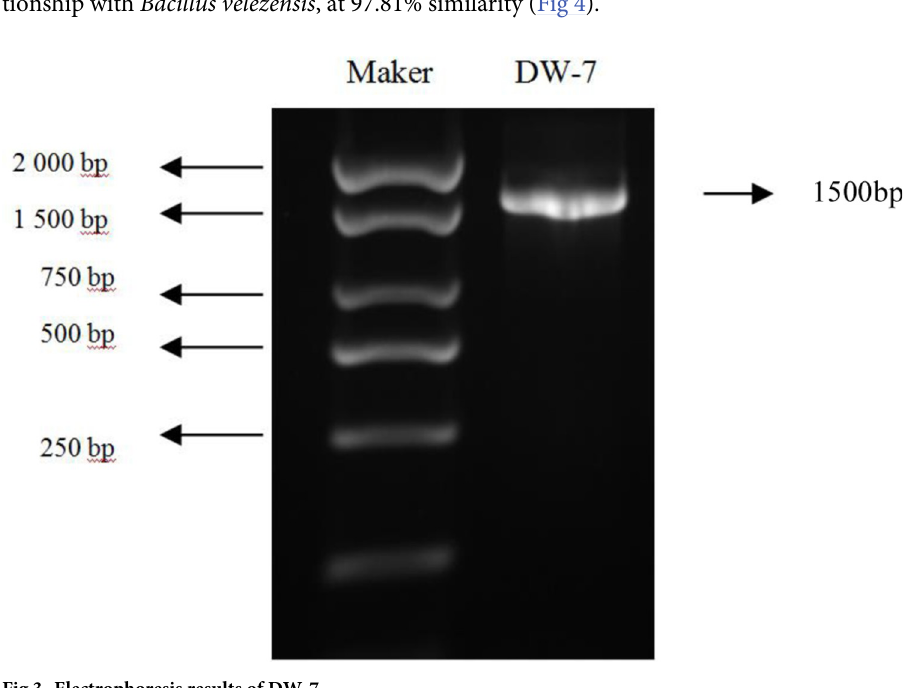
Fig 3. Electrophoresis results of